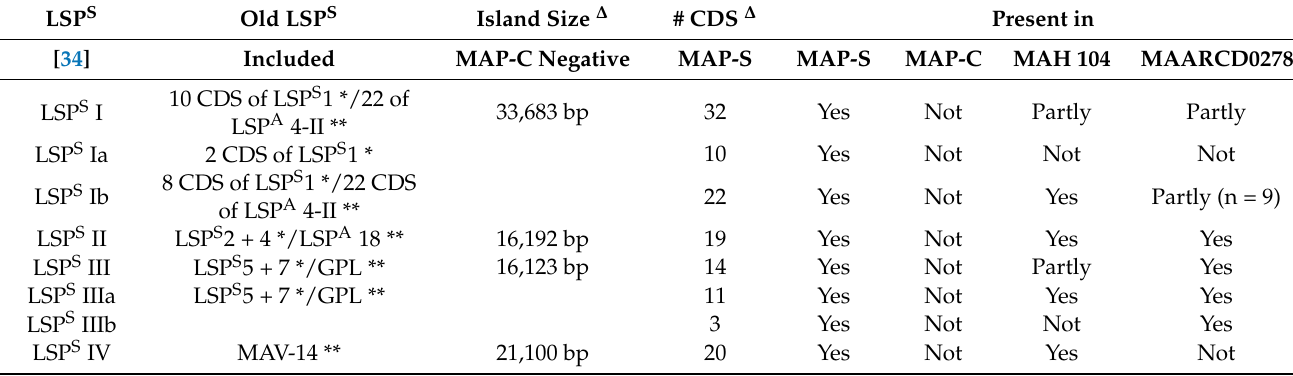
Table 6. Confirmed MAP-S specific large sequence polymorphisms (LSP S ) regions I–IV. All protein coding genes (CDS) belonging to these regions in individual MAP-S, MAH, and MAA strains are presented in supplemented Table